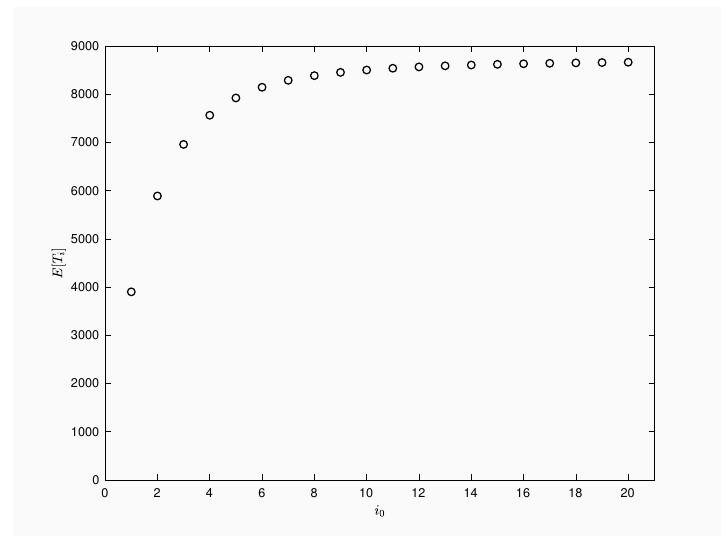
Figure 3. Expected number of inspections versus initial